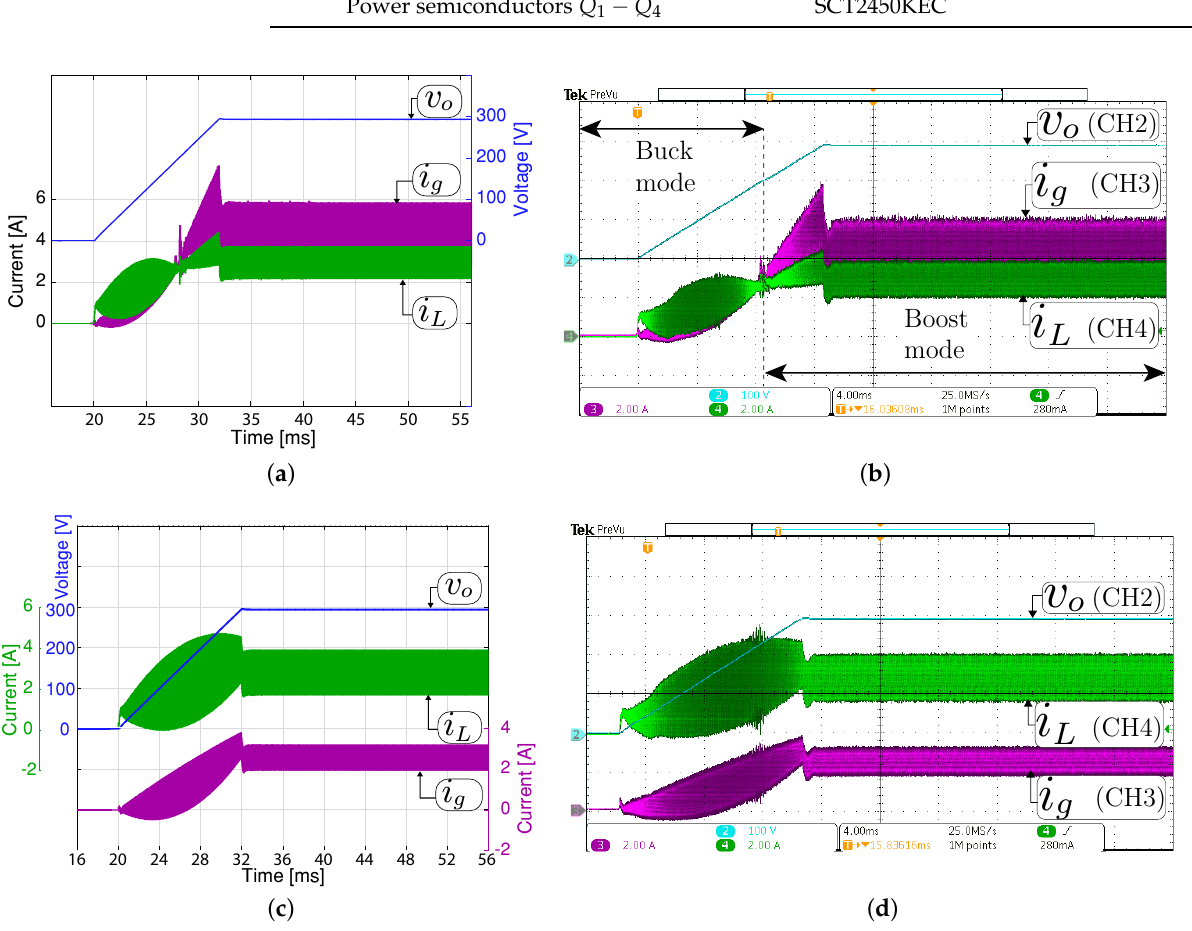
Figure 7. System startup with a constant resistive load. Simulated ( a , c ) and experimental ( b , d ). Two operation modes in steady-state are shown: ( a , b ) boost mode ( V g = 200 V, v o = 293 V and and R o = 200 Ω ) and ( c , d ) buck mode ( V g = 350 V, v o = 293 V and R o = 32.3 Ω ). CH1 or CH2: v o (100 V/div), CH3: i g (2 A/div), CH4: i L ( 2A/div), and time base of